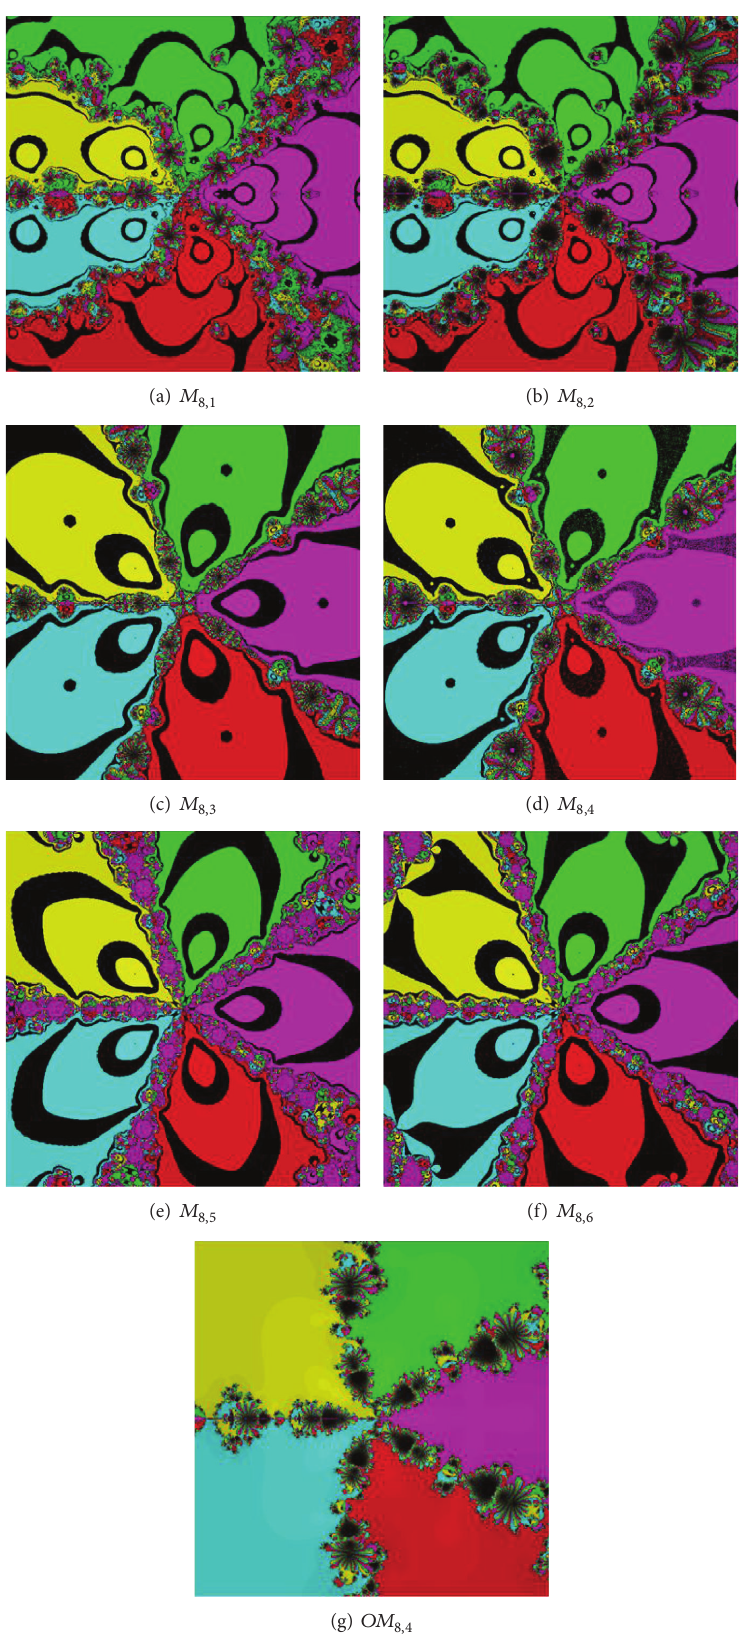
Figure 8: Basins of attraction for nonpolynomial 𝑃 4 (𝑧) = (𝑧 4 − 1/𝑧)